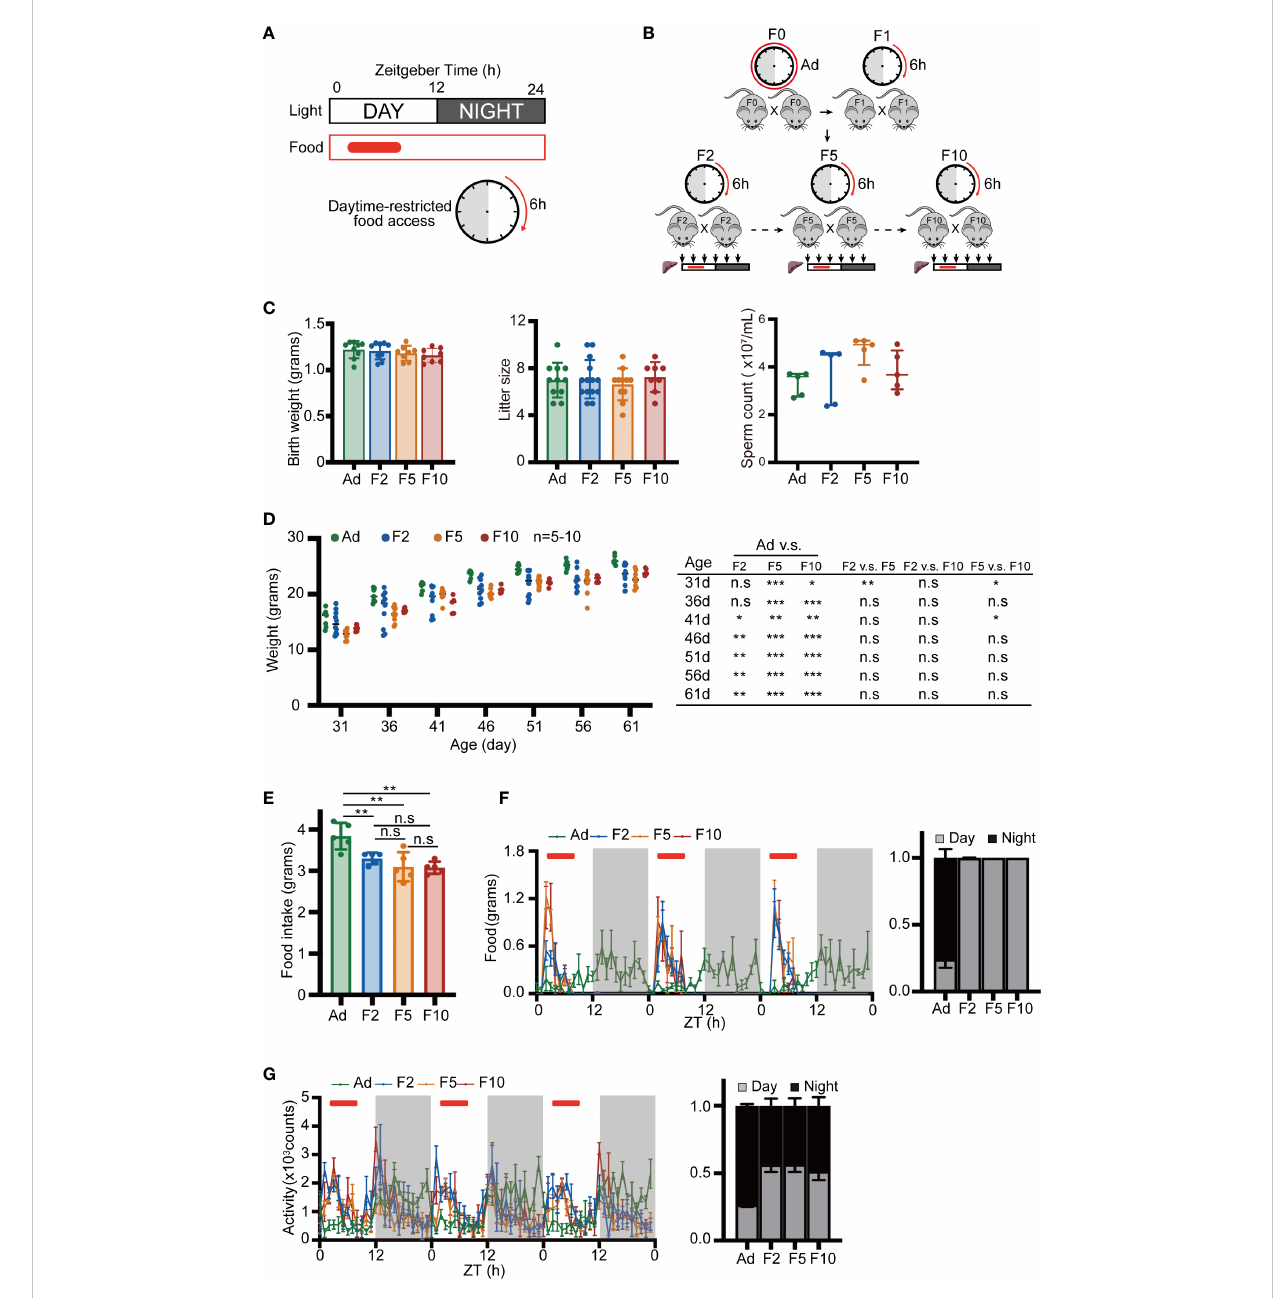
FIGURE 1 Basic behavior and metabolic measurements. (A) Schematic showing the DRF schedules. Day and night are indicated above with white and gray bars. The solid red box and the clock pattern indicate the timing of food access. (B) Schematic diagram of the multigenerational DRF mouse model. The sampling time points are indicated by black arrows. (C) Body weight of neonatal mice (n = 8-9), litter size (n = 8-14) and sperm number of adult mice (n = 5). (D) Body weight recorded at 5-day intervals from 31 days to 61 days (n= 5-10) and P value from statistical hypothesis test. (E) Daily food intake (n = 5). (F, G) Activity and food consumption recorded at 20 min intervals for 3 days; red bars indicate the timing of food access (Ad group were fed ad libitum). Histograms show the daily percentage of activity and food consumption; day and night are indicated with gray and black bars (n = 4). Signi fi cance was calculated by unpaired two-tailed Student ’ s t test, or two-way ANOVA; * P < 0.05; ** P < 0.01; *** P < 0.001 were considered signi fi cant; n.s., not signi fi cant. Error bars represent the mean ±